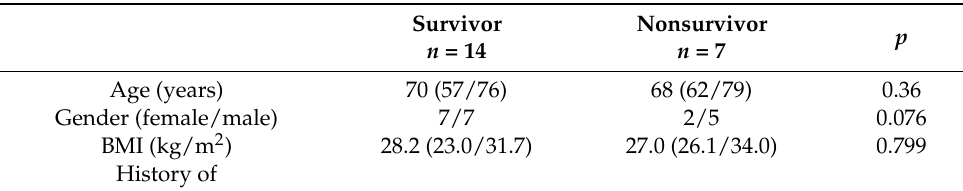
Table 1. Survivor and nonsurvivor demographic data and medical history at intensive care unit (ICU) admission.